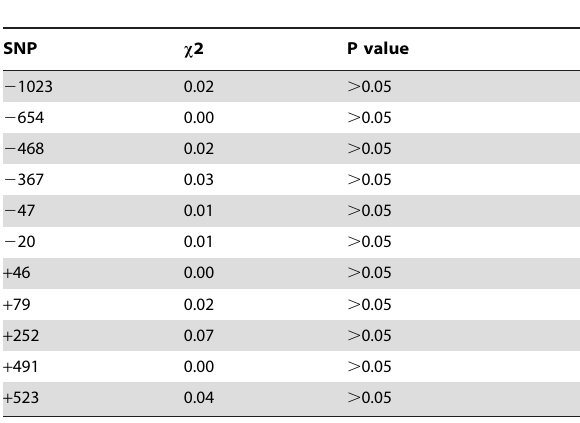
Table 4. Hardy Weinberg equilibrium value ( x 2) for each ADR b 2